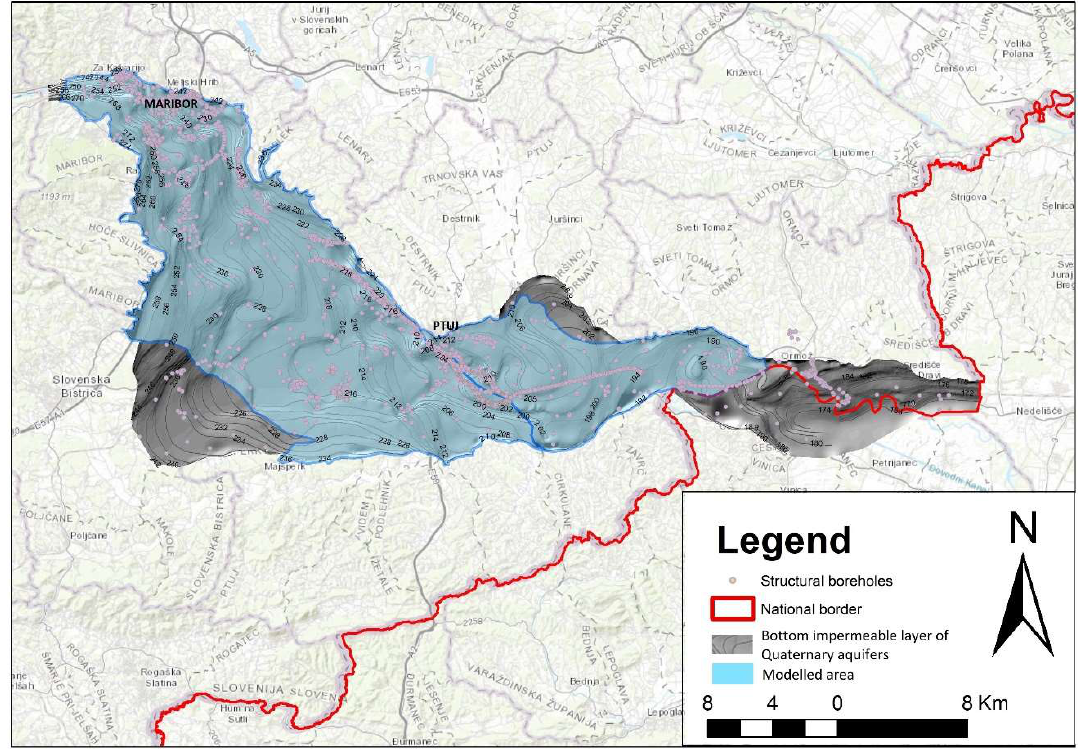
Figure 3. The modelled bottom impermeable layer of Quaternary aquifers.